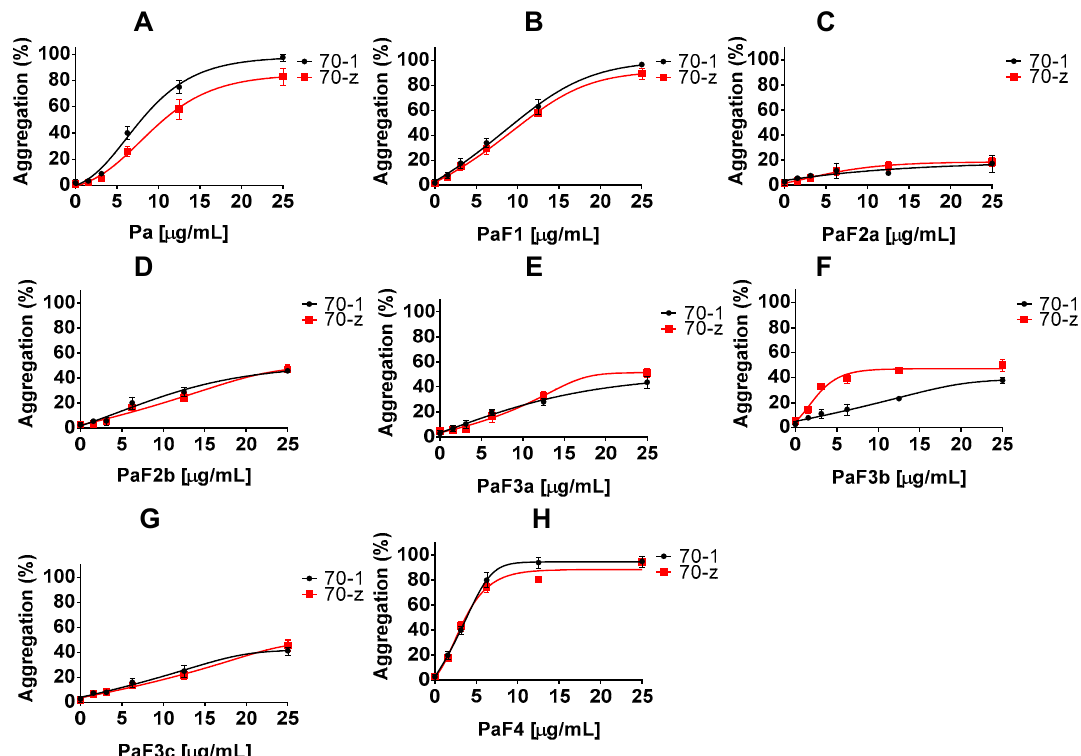
Figure 1. P. angolensis extracts suppress chaperone function of PfHsp70-1 and PfHsp70-z. The chaperone function of PfHsp70-1 and PfHsp70-z was investigated by monitoring the heat induced aggregation of MDH in the presence of PfHsp70-1/PfHsp70-z (chaperone) in vitro at 48 ◦ C for 60 min. The resultant heat induced aggregation of MDH was estimated by taking readings at 360 nm. The values were normalized to the aggregation of spontaneous MDH aggregation in the absence of PfHsp70-1 (70-1)/PfHsp70-z (70-z). The assay was repeated in the presence of the various plant extracts and represented by various panels: ( A ) Pa, ( B ) PaF1; ( C ) PaF2a; ( D ) PaF2b; ( E ) PaF3a; ( F ) PaF3b; ( G ) PaF3c; ( H ) PaF4. Standard deviations obtained from three replicate assays are